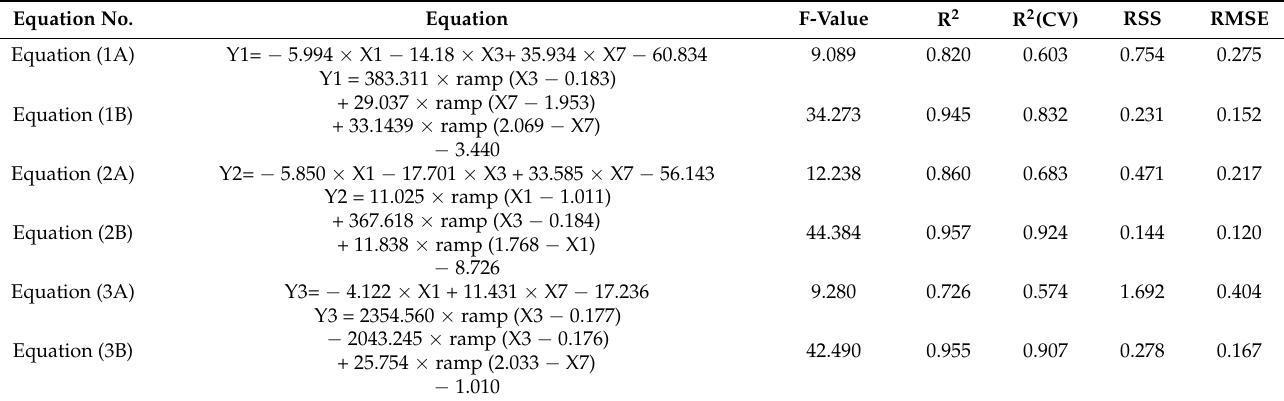
Table 2. Equations of the lines of best fit for predicting the values of Y1 (G(H*)), Y2 (G(C*OOH)), and Y3 (G(O*CHO)) for the